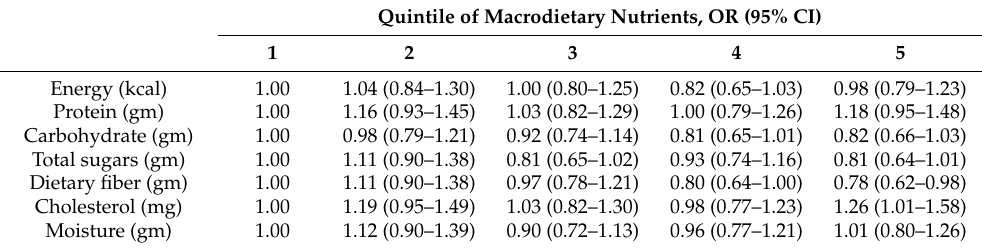
Table 2. Univariate logistic regression analysis of the association of macrodietary nutrients with self-reported eye affliction/retinopathy in individuals with diabetes.